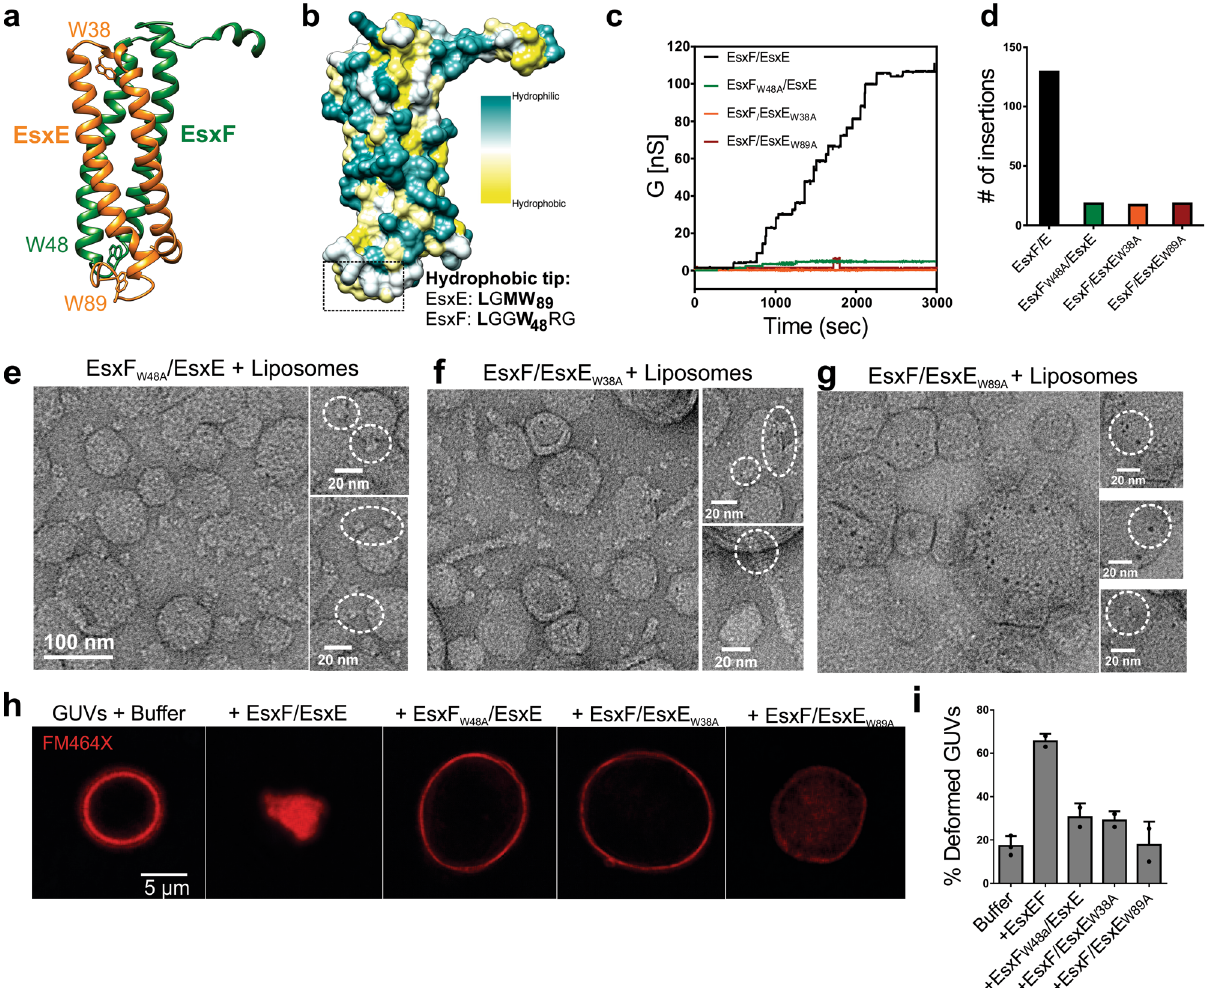
Fig. 5 The WXG motif is required for pore-forming activity. a Homology model of EsxE-EsxF indicating the location of the WXG motifs and the EsxE C- terminal GXW motif. The respective tryptophans are highlighted. b Hydrophobicity plot of the EsxE-EsxF complex. Some of the residues forming the hydrophobic tip are highlighted. c Current trace of wt EsxE-EsxF and the WXG variants in 25 mM sodium phosphate (pH 6.5), 1 M KCl in diphytanoyl phosphatidylcholine bilayers. d Total channel insertion events for the indicated proteins. e – g Electron micrograph of negatively stained dimyristoyl- phosphatidylcholine liposomes incubated with EsxF W48A /EsxE, EsxF/EsxE W38A , and EsxF/EsxE W89A at pH 6.5 for 30 min. Selected fi eld of views are shown. Scale: 100 nm unless otherwise indicated. Data are from a single EM session. Representative images are shown from a total of ~25 fi elds of view per sample. h Giant unilamellar vesicles (GUVs) were treated with the dye FM464X to label the lipid membranes and were then incubated with 40 µ g wt EsxE- EsxF or the WXG variants in a buffer containing 25 mM sodium phosphate (pH 6.5) and 150 mM NaCl. Representative of two experiments. Representative micrographs are shown. i Quanti fi cation of the experiments shown in h . The values are averages from two independent experiments shown as the mean ± standard deviation. Source data are provided in the Source data fi